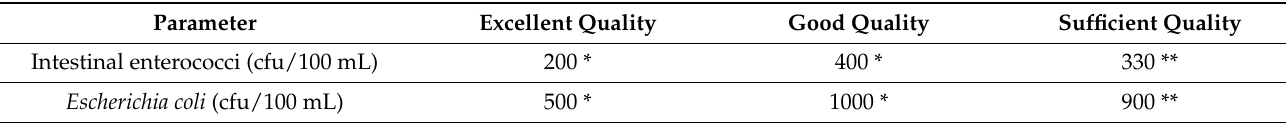
Table 5. The requirements for surface water [66].